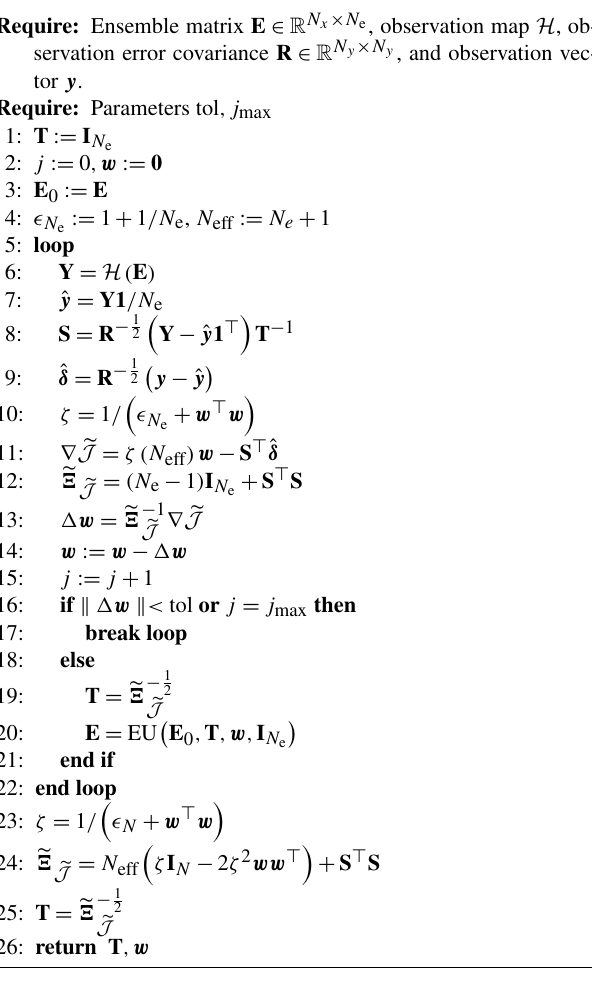
Algorithm A10 Finite size ensemble transform (FSET).